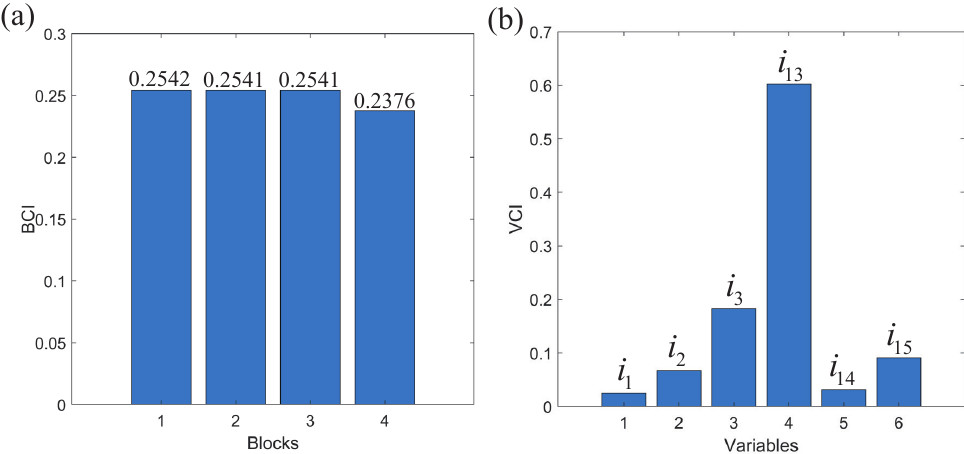
Figure 16. The anomaly isolation results of anode slippage in aluminum electrolysis process. ( a ) BCI; ( b ) VCI-Block 1.